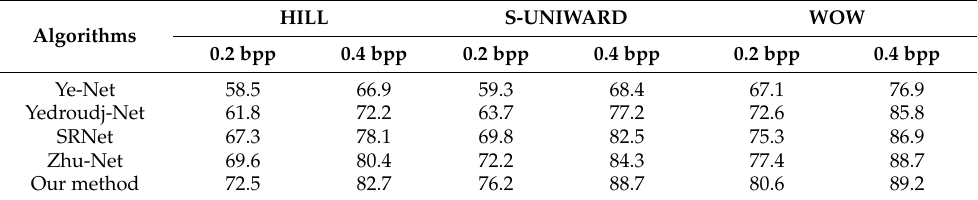
Table 3. Detection accuracy (%) of multiple CNN-based steganalysis methods against HILL, S- UNIWARD, and WOW at 0.2 bpp and 0.4